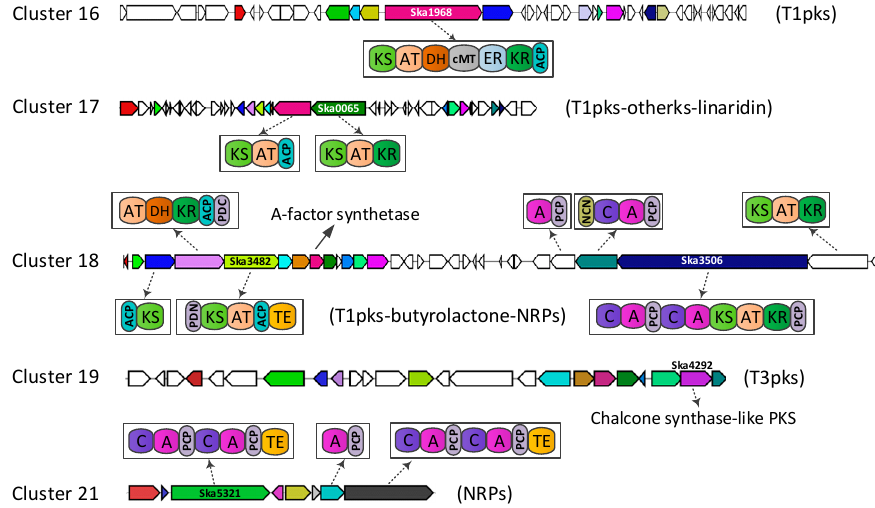
Figure 1. Proposed PKS/NRPs module and domain organization in five clusters. PKS: polyketide biosynthase, NRPs: nonribosomal peptide synthetase, KS: ketosynthase, AT: acyltransferase, DH: dehydratase, ER: enoyl reductase, KR: ketoreductase, ACP: acyl carrier protein, cMT: C -methyl transferase, PCP: peptidyl carrier protein, C: condensation, A: adenylation, PDN: PKS docking N- term, PDC: PKS docking C-term, NCN: NRPS-COM N-term, TE: thioesterase.